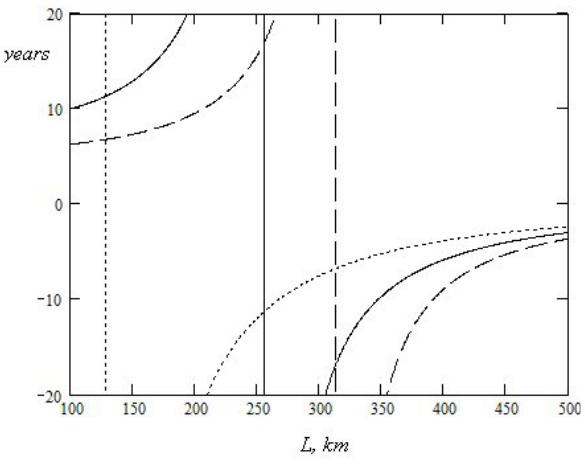
Fig. 1. Period of rotation of the Rossby wave train in years versus the waveguide width (mean distance between the SAF and PF), in km for different magnitudes of the mean current: 2 cm/s - dots, 8 cm/s - solid line, 12 cm/s - dash line. The negative period indicates that the Rossby wave train propagates against the mean current